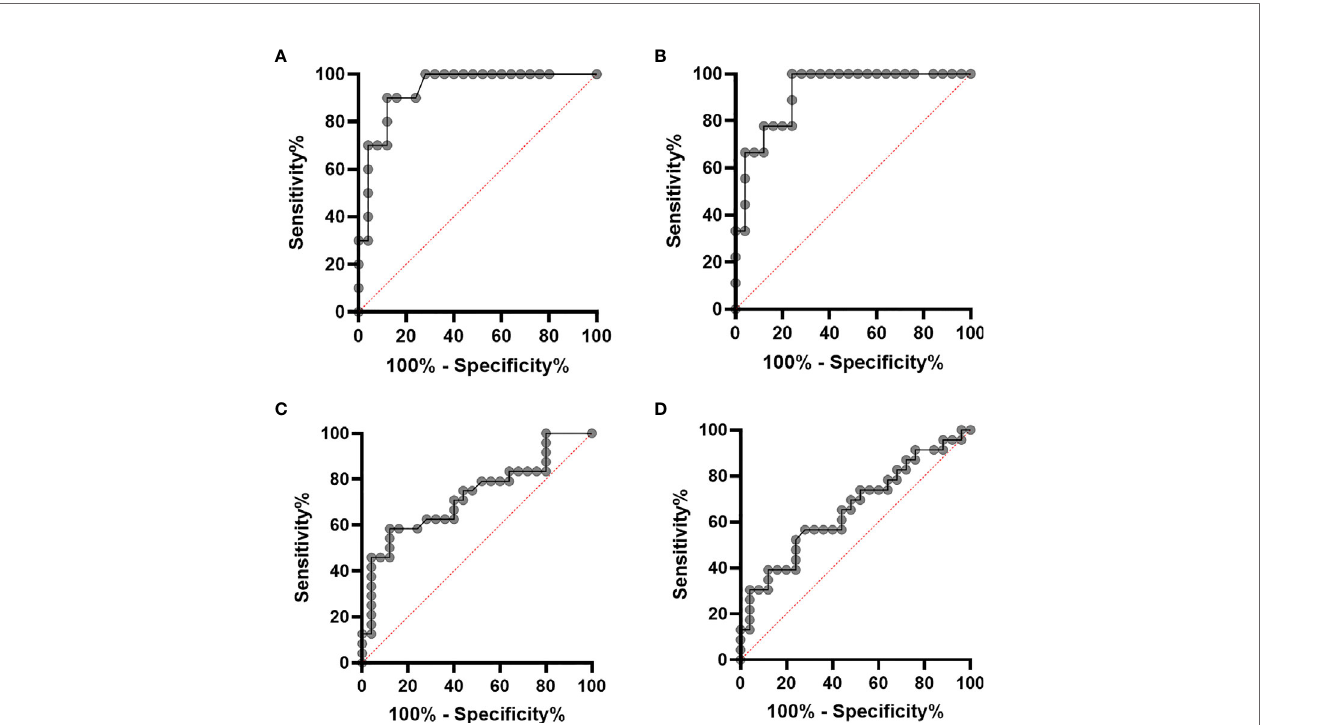
FIGURE 4 | pSTAT1 levels in monocytes distinguish patients with sHLH/MAS not treated with glucocorticoids at sampling from patients with active sJIA or with other rheumatic diseases. (A, B) receiver operating characteristic (ROC) curve of pSTAT1 levels in unstimulated (A) and IFN g (10 ng/ml) – stimulated (B) monocytes distinguishing patients with sHLH/MAS not treated with glucocorticoids at sampling from patients with active sJIA or with other rheumatic diseases. (C, D) ROC curve of pSTAT1 levels in unstimulated (C) and IFN g (10 ng/ml) – stimulated (D) monocytes distinguishing all patients with sHLH/MAS (not treated and treated with glucocorticoids at sampling) from patients with active sJIA or with other rheumatic